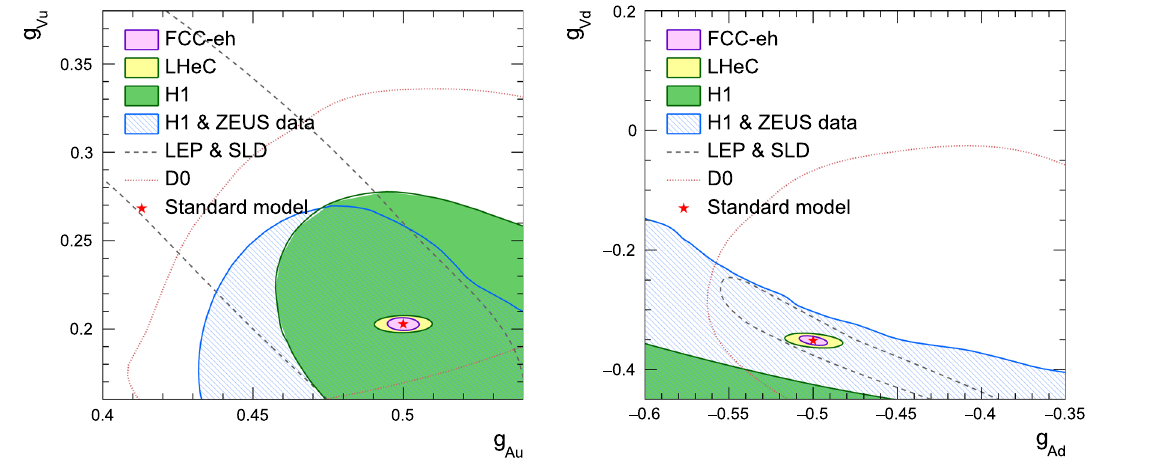
tours of the present measurements are truncated to a large extent. For comparison, also the prospects for the LHeC are displayed. A global fit to the light-quark EW couplings, including the FCC-ee projections, is shown in Fig. 8.8 and in Table